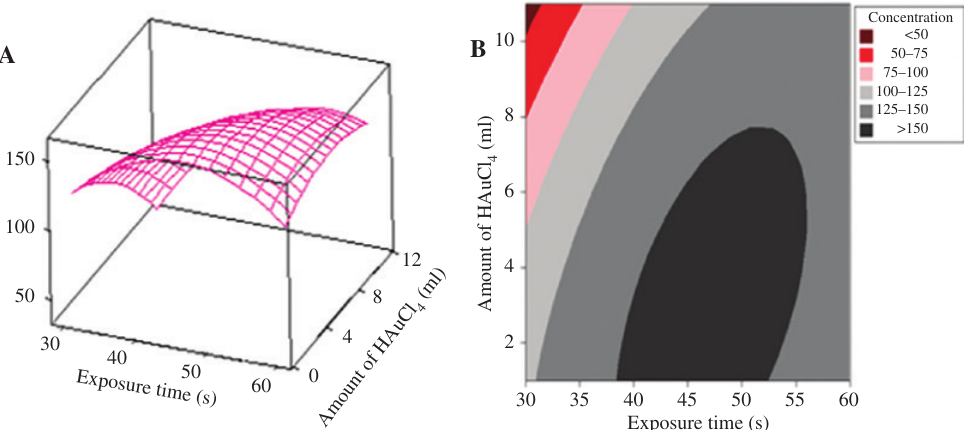
Figure 3: Response surface (A) and contour plots (B) for AuNP concentration of produced NPs solution as function of significant (p < 0.05) interaction effects of microwave exposure time and amount of HAuCl 4